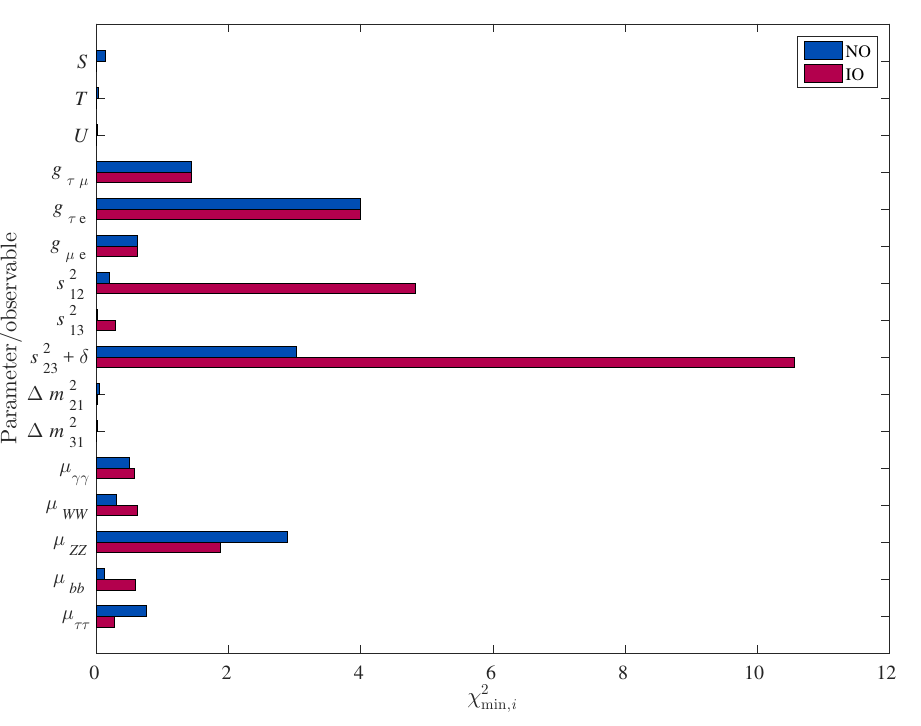
Figure 2. Individual contributions to (cid:31) 2 and IO. The number of standard deviations that each observable i is away from the observed value is given by the respective pull